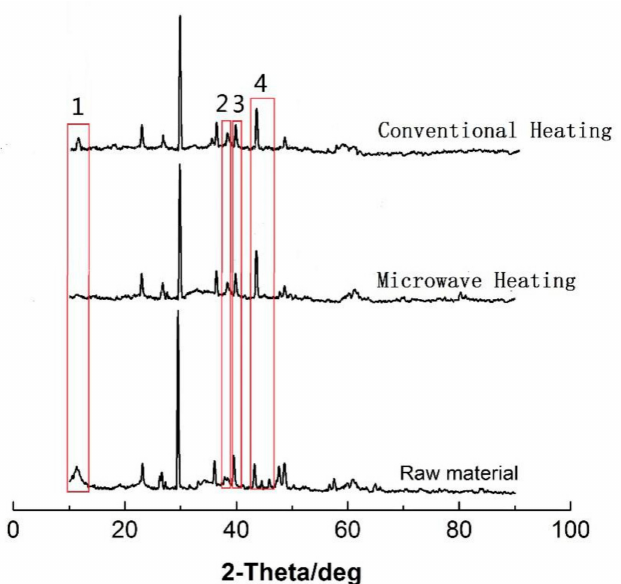
Figure 8. XRD (Shimadzu XRD-7000S / L) patterns of the products roasted at 450 ◦ C for 10 min by microwave and conventional